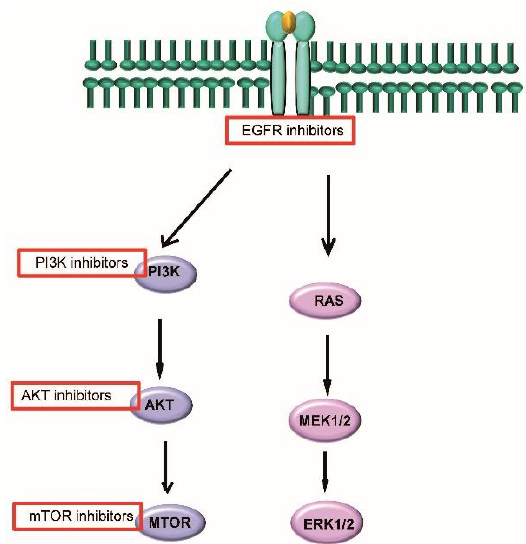
Figure 2. A short overview of targetable oncogenic pathways in HPV+ HNSCC.